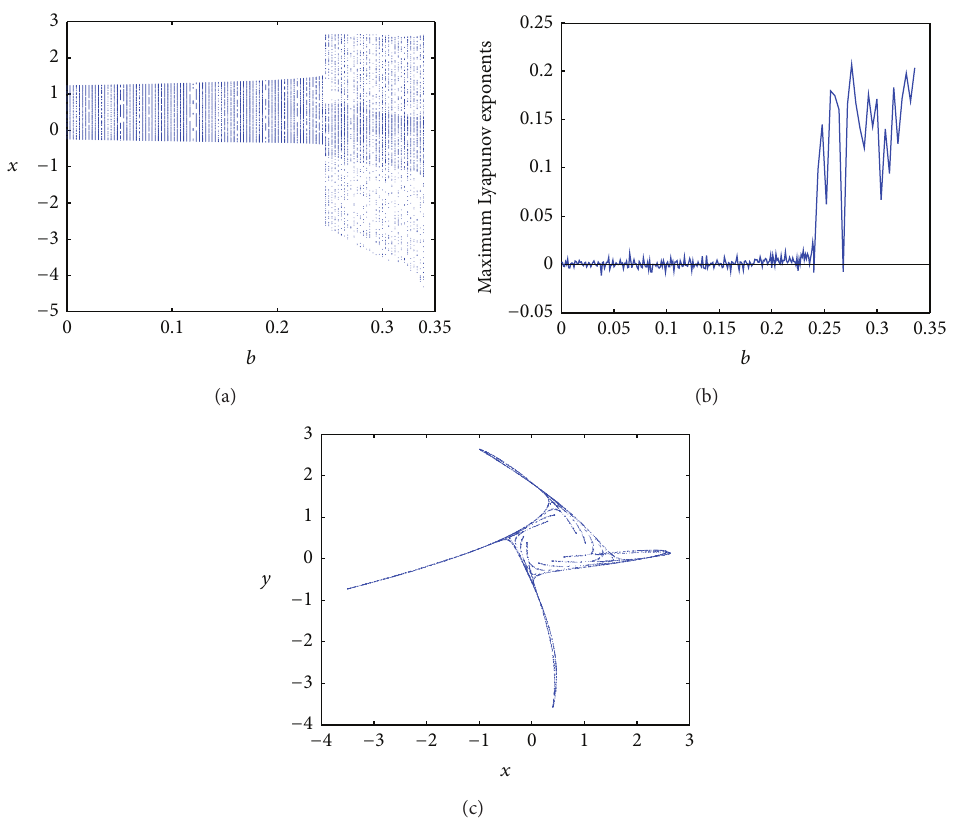
Figure 1: (a) Bifurcation diagram of map (2) in (𝑏,𝑥) plane for 𝑎 = −1.5 , 𝑐 = 0.8 , 𝑑 = 0.1 , and 𝑒 = 0.1 . (b) Maximum Lyapunov exponents corresponding to (a). (c) Phase portrait of the chaotic attractor for 𝑎 = −1.5 , 𝑏 = 0.3 , 𝑐 = 0.8 , 𝑑 = 0.1 , and 𝑒 = 0.1